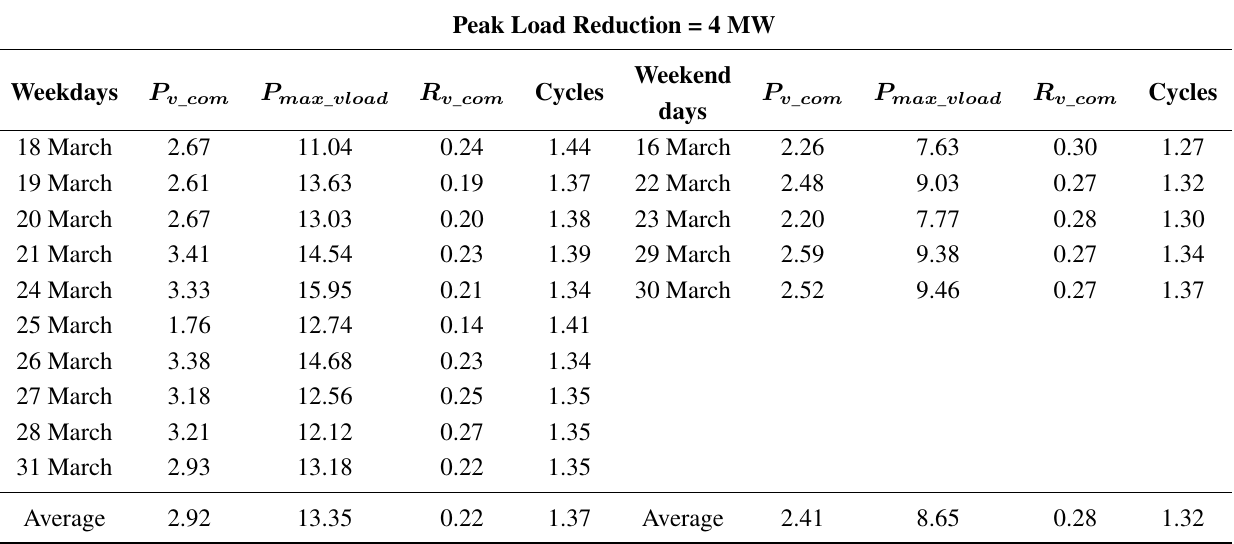
Table 1. Valley compensation of weekdays and weekend days.